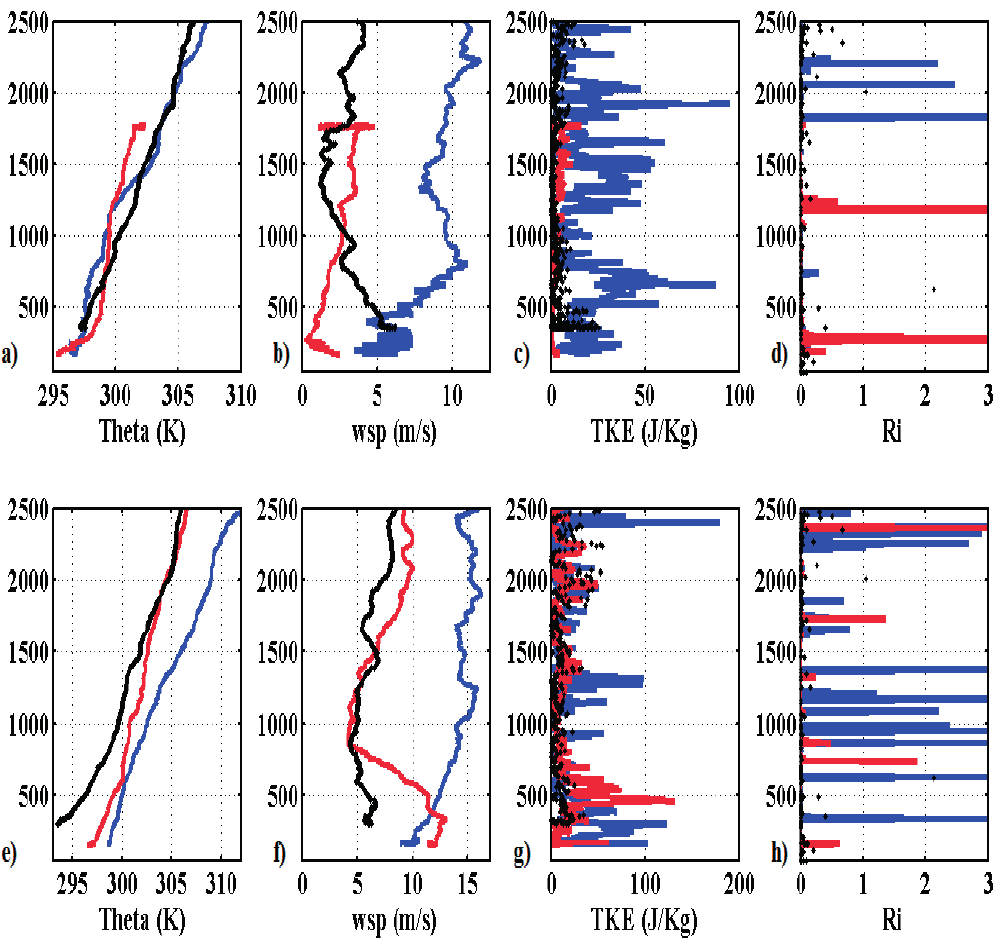
Figure 7. Aircraft profiles over the coastal GOM of ( a ) potential temperature (K); ( b ) horizontal wind speed (m/s); ( c ) turbulent kinetic energy (TKE, J/kg); and ( d ) Richardson number values; Corresponding observations of the same parameters over the Western Atlantic/Eastern GOM are shown in ( e – h ). Blue lines represent observations on 7/20, red 7/21 and black